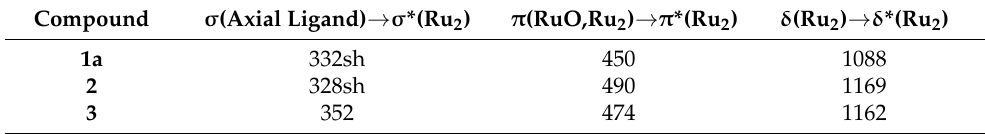
Table 3. Assignment of the absorption bands observed in the spectra of compounds 1a , 2 and 3